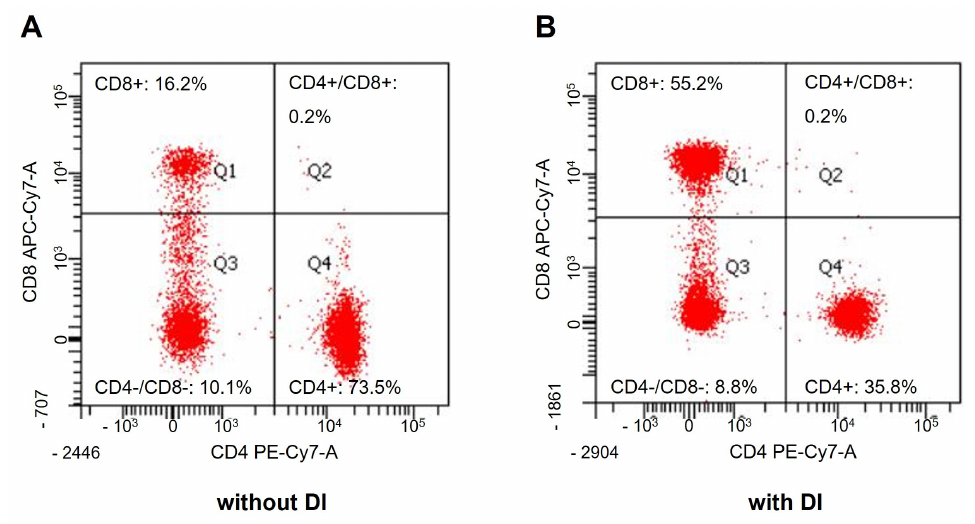
Figure 3. Representative flow cytometry images after CD4+/CD8+ immunostaining. ( A ) The per- centage of CD4+ and CD8+ T cells in TB patients without DI. ( B ) The percentage of CD4+ and CD8+ T cells in TB patients with DI.